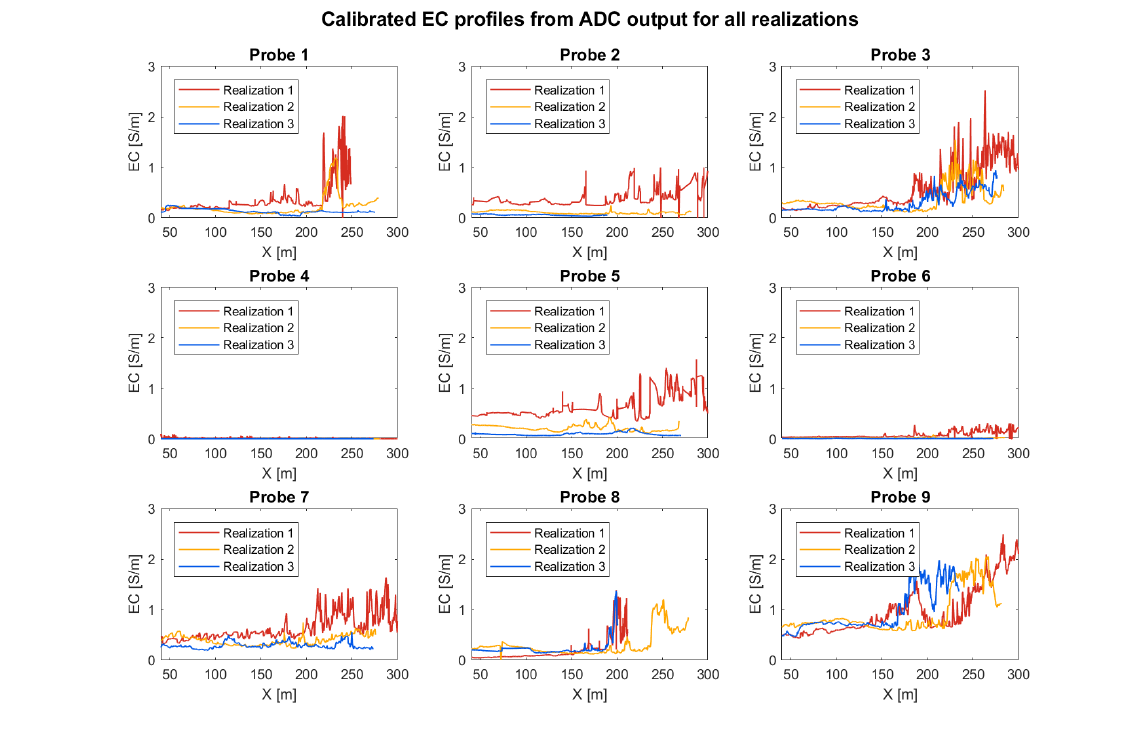
Figure 17. Measured electrical conductivity (EC). Analog digital converter